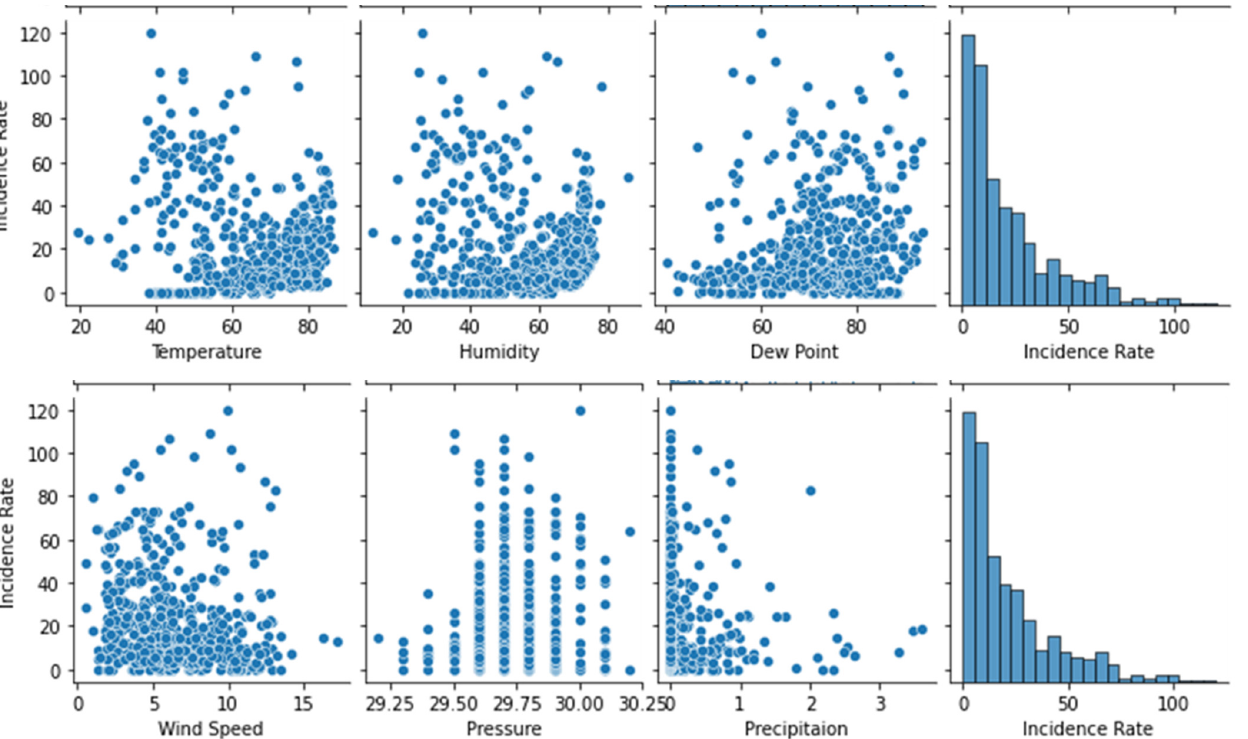
Figure 2. A scatter plot of COVID-19 incidence rate against each of the weather data variables (Temperature, Humidity, Dew Point, Wind speed, Pressure, and Precipitation) in Mississippi 22 January 2020 to 4 August 2021.